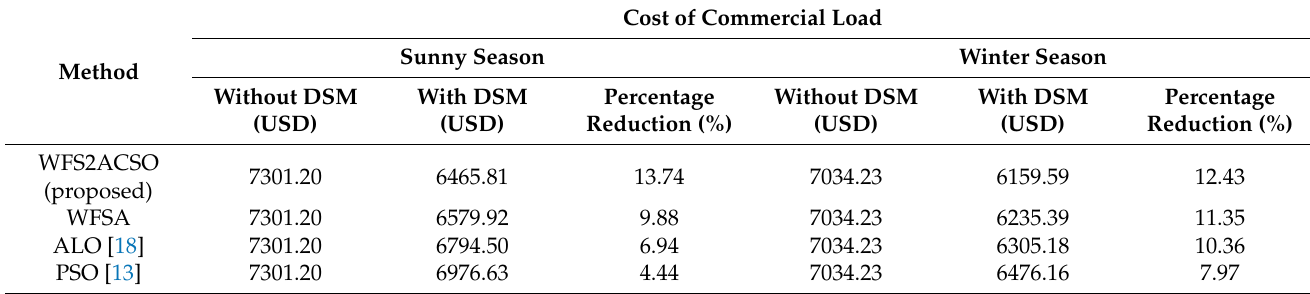
Table 7. Comparison of percentage cost reduction for different optimization methods for commercial load.